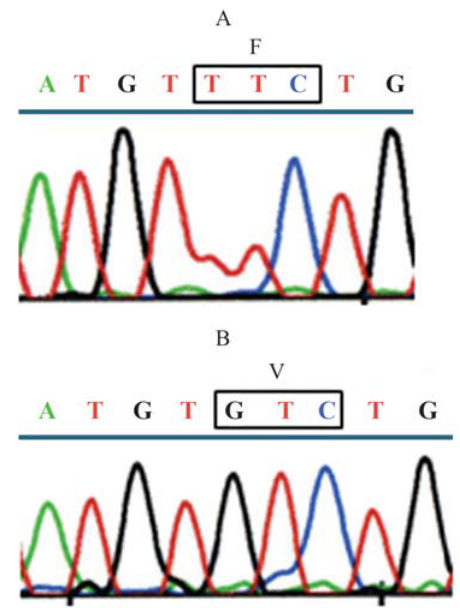
Figure 2 - Sequence analysis of the JAK2 gene in AML. Sequencing iden- tified G to T transversion at nucleotide 1849, resulting in the V617F muta- tion in the AML sample (A, AML02). Wild-type sequences are shown as control (B, MM01).